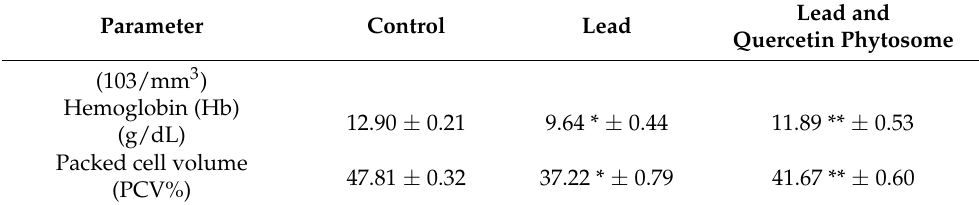
Table 1. Cont. Parameter